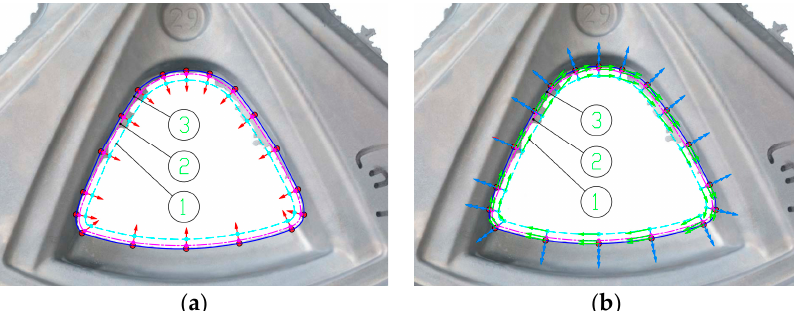
Figure 14. Tool locations planning of the layered deburring: ( a ) tool contact positions; ( b ) tool contact orientations.